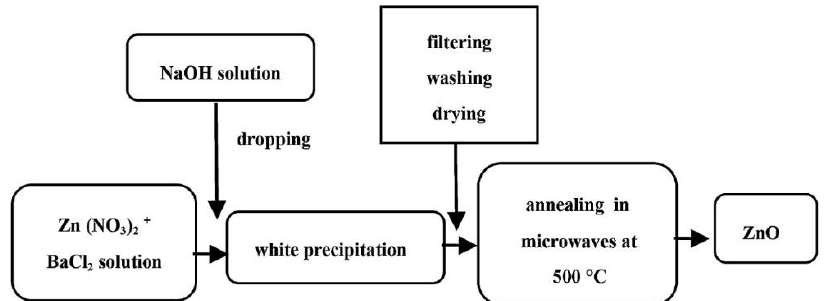
Figure 78. Schematic of the experimental procedure. Products synthesised by the microwave assisted